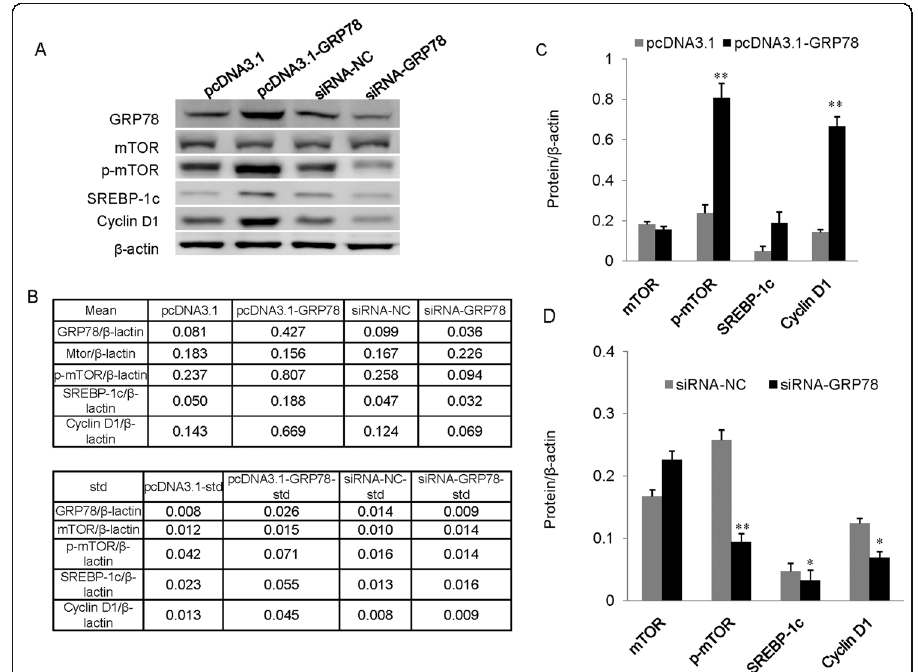
Fig. 4 GRP78 is a positive regulator of the mTOR signaling pathway. a BMECs were transfected with pcDNA3.1-GRP78 vector or GRP78siRNA. Cells transfected with the empty vector (pcDNA3.1) or scramble siRNA were used as negative controls. The indicated protein levels were detected using western blotting analysis. β -actin served as a loading control. b Relative fold changes inGRP78 protein levels (protein/ β -actin) in ( a ) were quantified using grayscale scanning. c and d Relative fold changes of indicated protein levels (protein/ β -actin) were quantified using gray scale scanning after over expression ( c ) or silencing ( d ) of